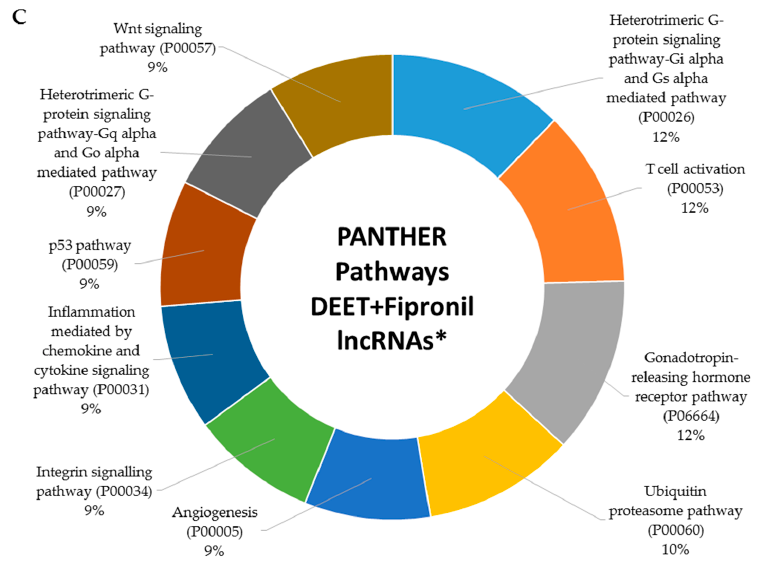
Figure 6. Top 10 signaling pathways affected by exposure of primary human hepatocytes to ( A ) 100 µ M DEET; ( B ) 10 µ M fipronil; and ( C ) 100 µ M DEET plus 10 µ M fipronil. * Assignments were made using PANTHER analysis of dysregulated lncRNAs and “associated” protein-coding genes (as determined using the GREAT algorithm as described in the Methods section). Letters and numbers in parenthesis are PANTHER identifiers.